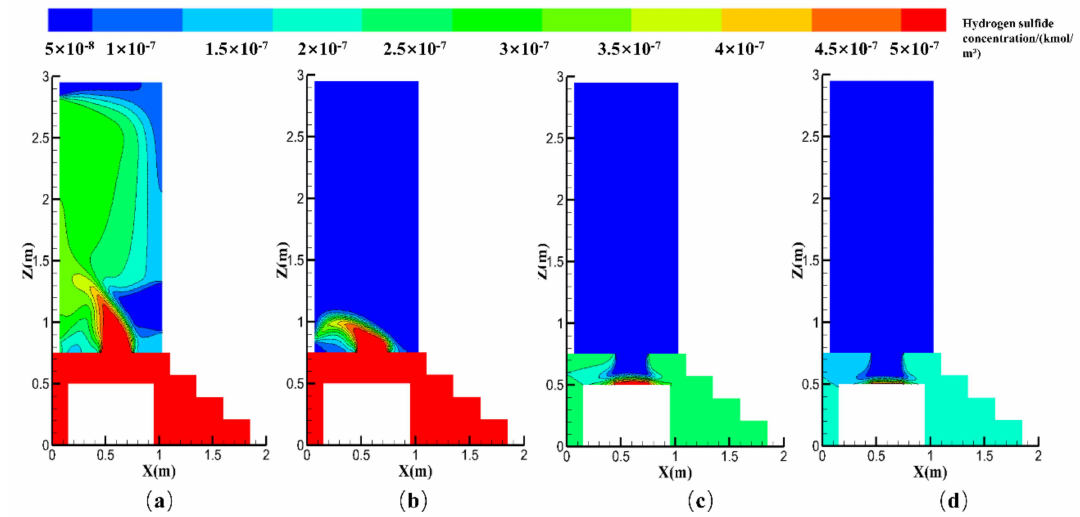
Figure 6. Hydrogen sulfide concentration distributions at different ACH (unit: h − 1 ) values for Cases 1 and 2. Case 1: ( a ) ACH = 5, ( b ) ACH = 10; Case 2: ( c ) ACH = 5, ( d ) ACH =